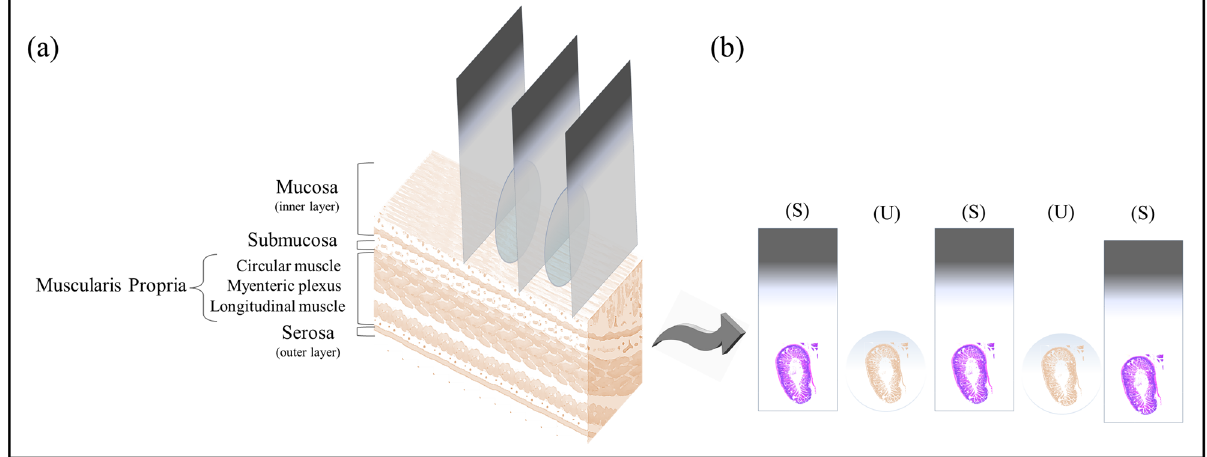
Figure 1. ( a ) Illustration of intestinal tissue demonstrating the multiple layers of the colon, from the serosa (outer) to the mucosa (inner). ( b ) H&E staining was used in every other tissue section of 5 µm thickness to identify ganglion cells and correlate with the adjacent unstained tissue.